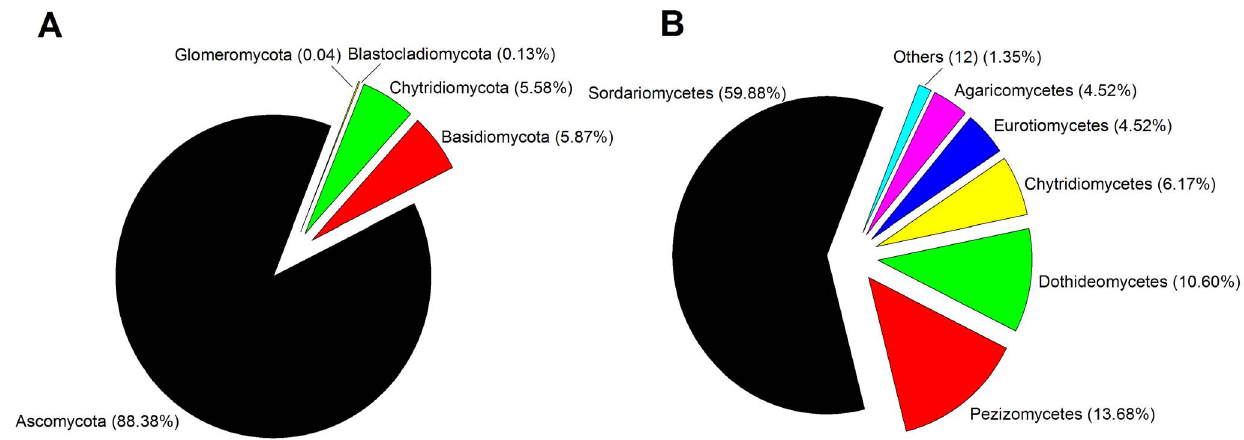
Figure 2. Composition of fungal community in the soil studied based on 28S rRNA gene pyrosequencing at phylum (A) and class (B) level.